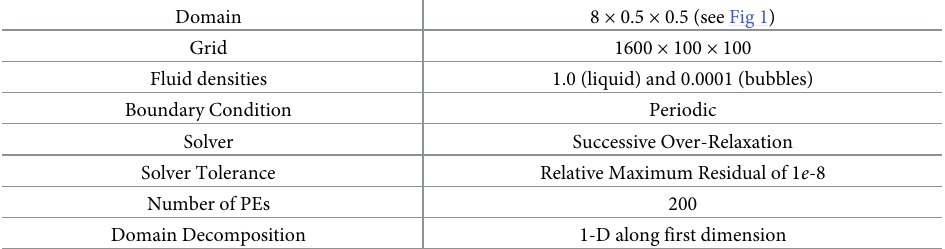
Fig 1. Bubbles in a liquid illustrating multiphase flows in a periodic 3-D domain. Only a small section of the domain is shown here. https://doi.org/10.1371/journal.pone.0277940.g001 Table 1. Parameters relevant to the simulation setup we consider in this